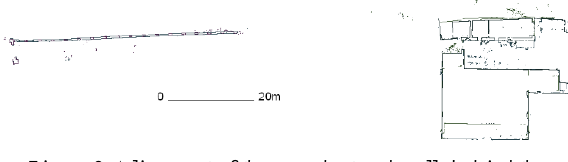
Figure 6. Alignment of the aqueduct and walls behind the house.